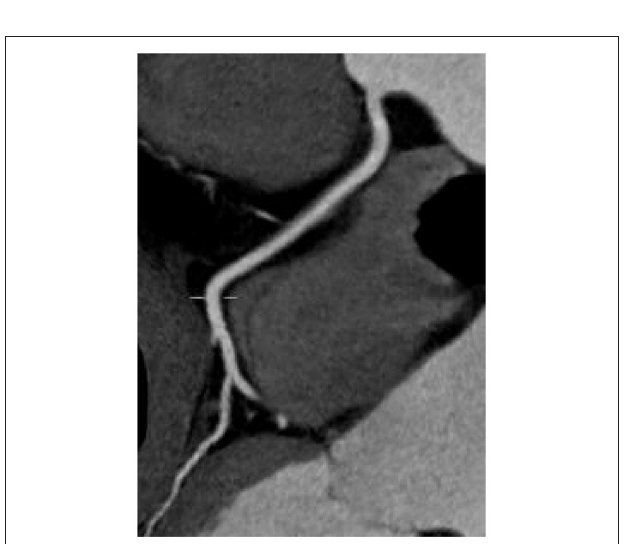
FIGURE 4 | Typical image of left anterior descending curved planar reconstruction in the observation group.